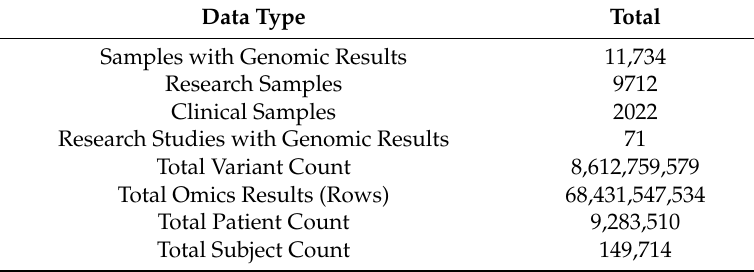
Table 5. Mayo Clinic genomic data warehouse data statistics.